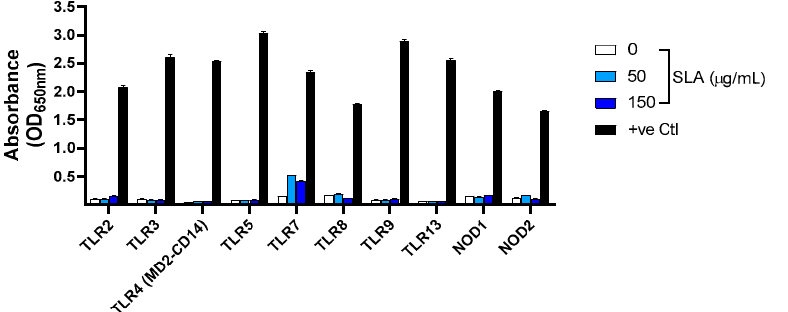
Figure 1. Stimulation of Pattern Recognition Receptors (PRRs) by SLA. HEK-293 cells expressing various PRRs were incubated with SLA or positive control stimulants. Expression of the reporter gene SEAP through receptor-mediated NF- κ B activation was determined through spectrophotometry on the following day. Data are presented as mean + SEM ( n = 3).